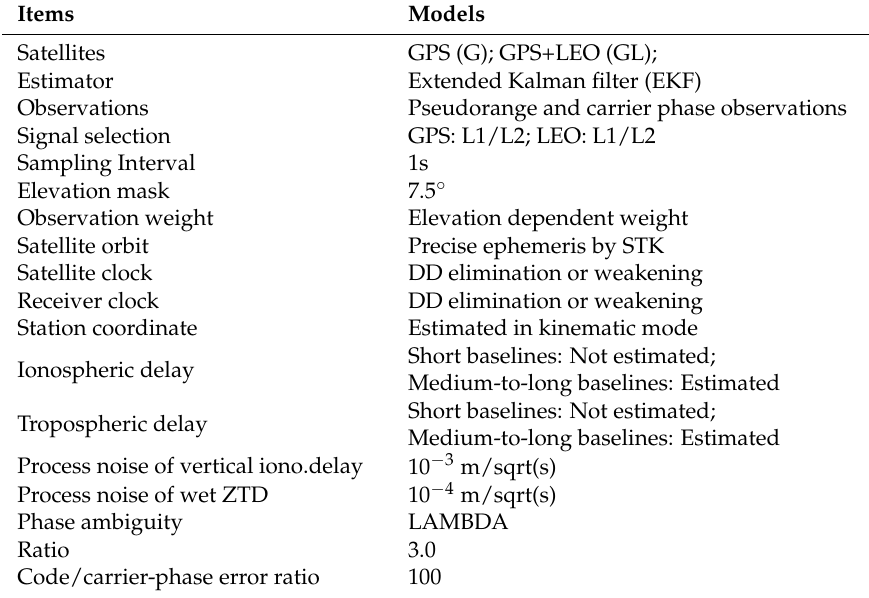
Table 4. Data processing strategy for LEO augmented GPS RTK (real-time